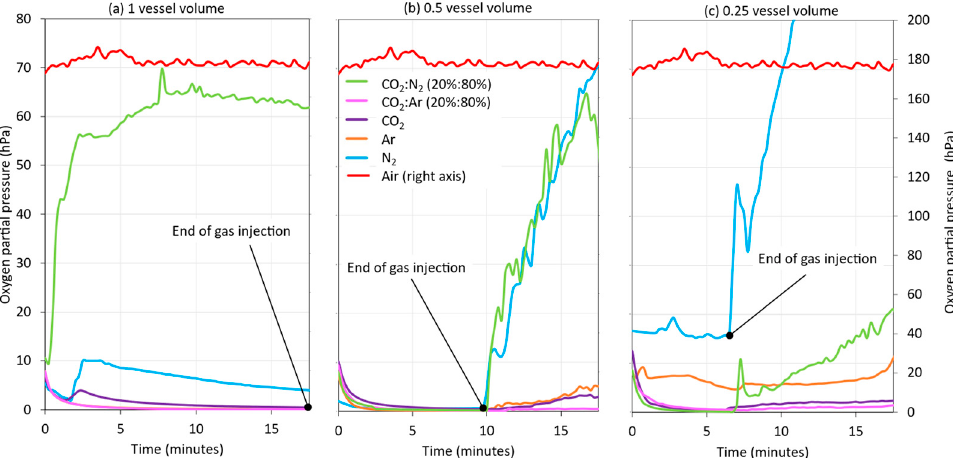
Figure 9. Monitoring of the oxygen content in the HSO of the racked tank by inerting the wine with different gases and different volumes of each gas added: one vessel volume of inert gas ( a ); 0.5 vessel volume of inert gas ( b ); and 0.25 vessel volume of inert gas ( c ).